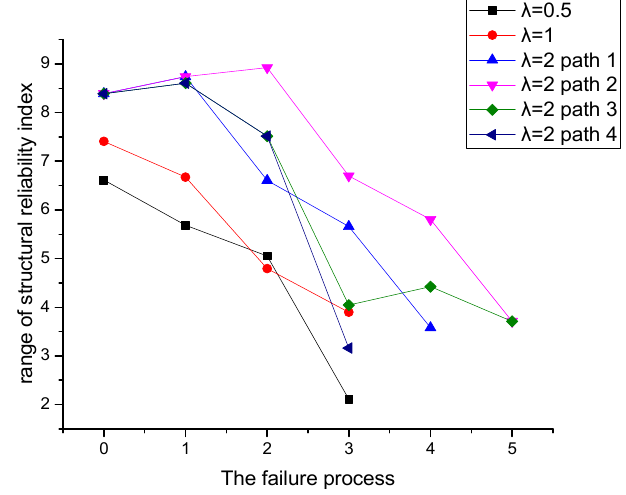
Figure 17. The range of the reliability index in the failure process.